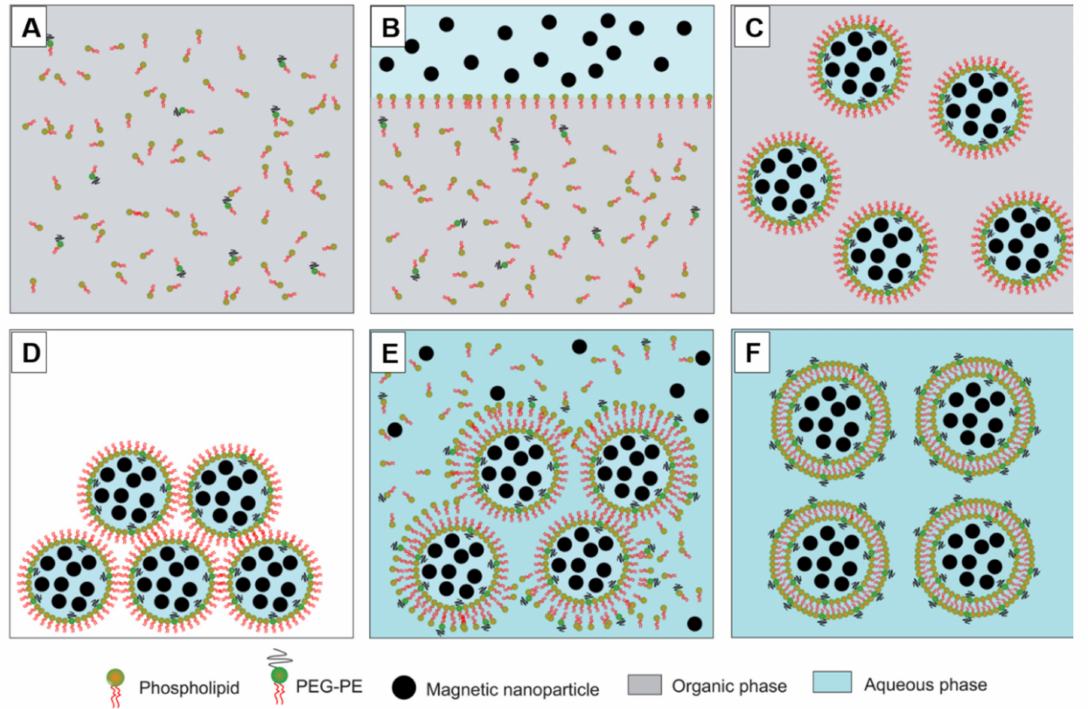
Figure 3. Diagram of ultra-magnetic liposomes (UMLs) or MCLs preparation by reverse phase evaporation method. Phospholipids were dissolved in organic phase (CHCl 3 + diethyl ether) ( A ); then, an aqueous phase containing MNPs was added ( B ); After 20 minutes of sonication, a water-in-oil emulsion was formed ( C ); Then, the organic solvent was evaporated, leading to the formation of a gel form ( D ); At the critical point, some vesicles were broken, and the excess phospholipid in the environment interacted with the residual micelles to complete the lipid bilayer, ( E ) leading to the formation of liposomes ( F